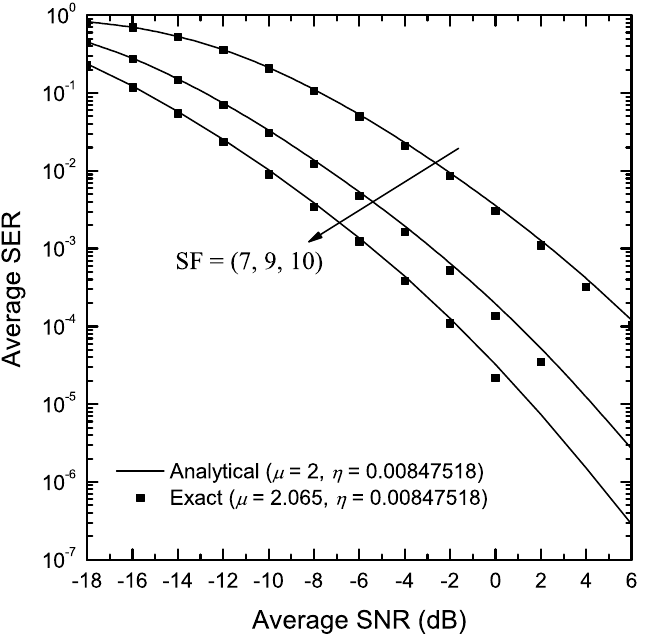
Figure 9. SER of LoRa systems operating in the presence of η - µ fading as a function of the SNR, γ , in an indoor environment, as reported in [27] and various values of